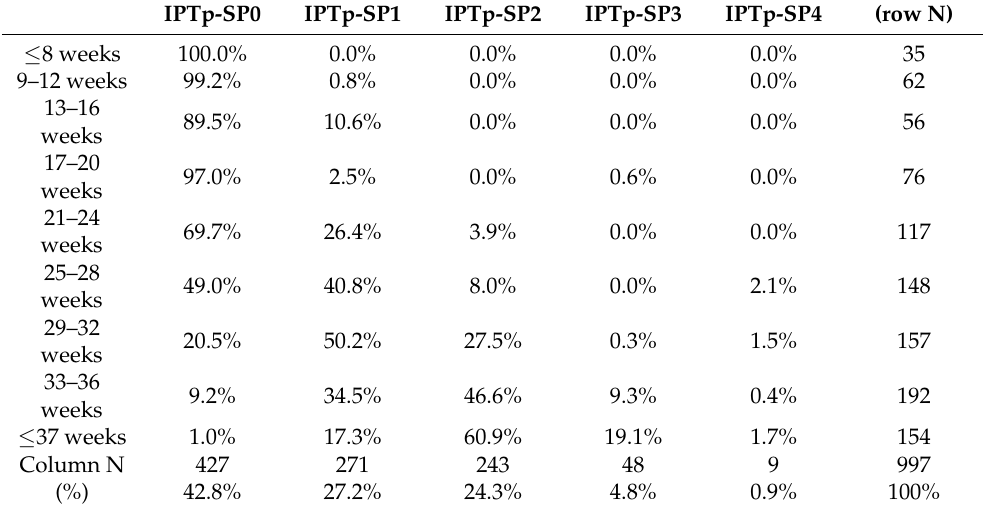
Table A2. Summary Statistics of Pregnant Women’s IPTp History and Gestational